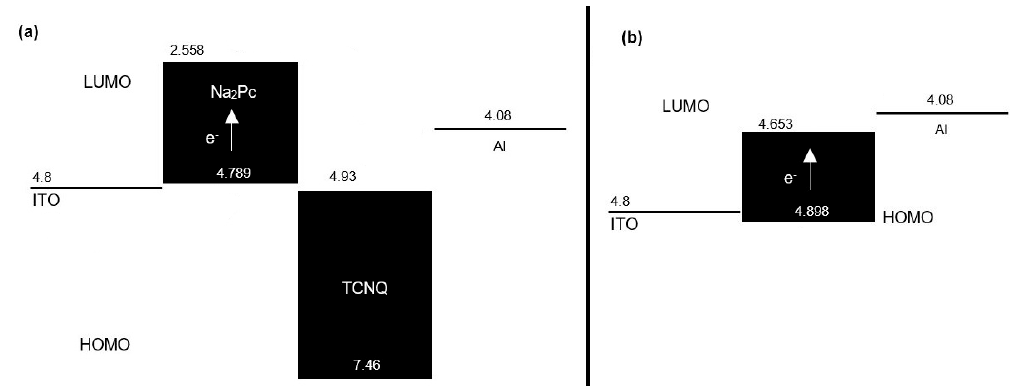
Figure 3. Energetic diagram for the devices of ( a ) flat heterojunction and ( b ) dispersed heterojunction.